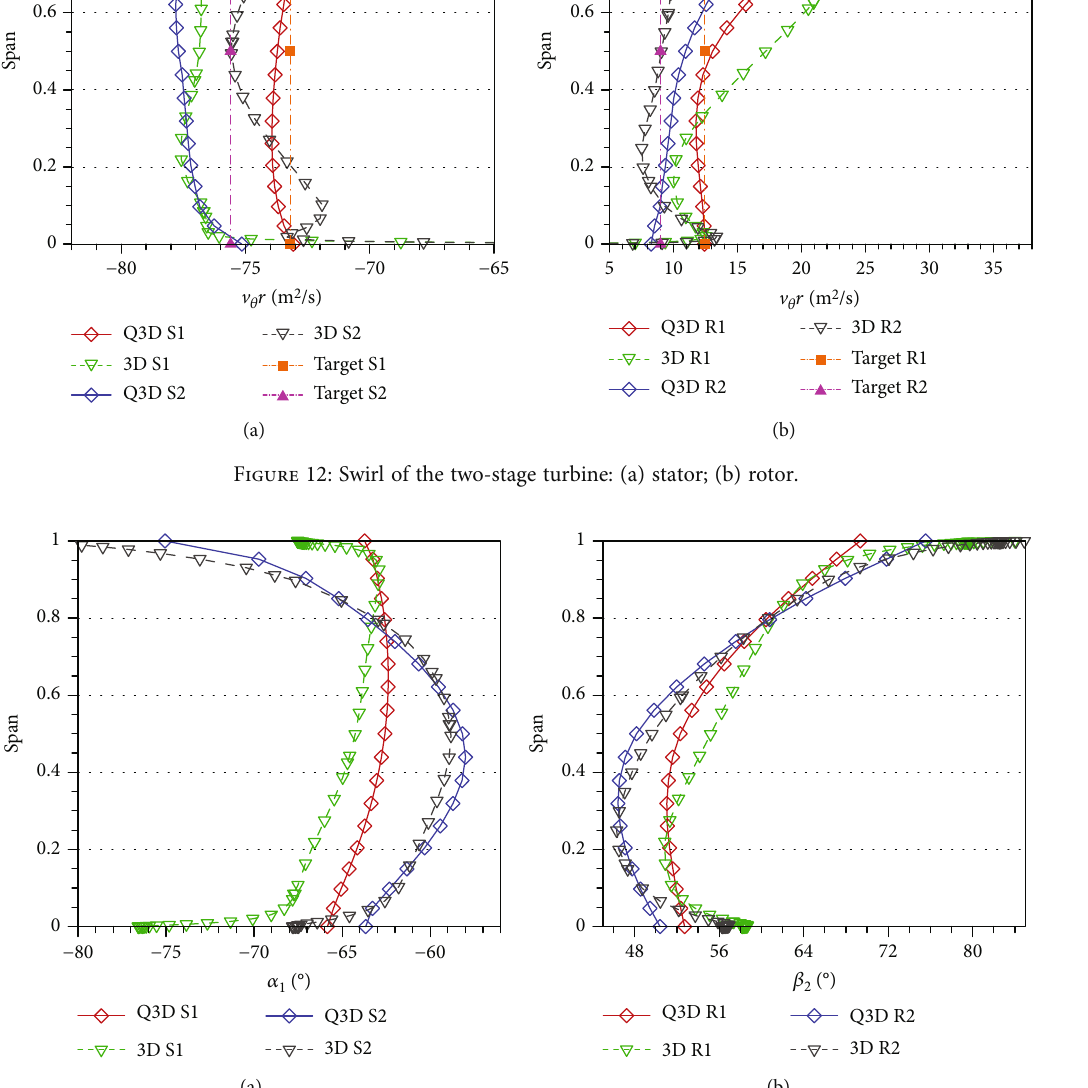
Figure 13: Flow angle of the two-stage turbine: (a) stator fl ow angle; (b) rotor relative fl ow